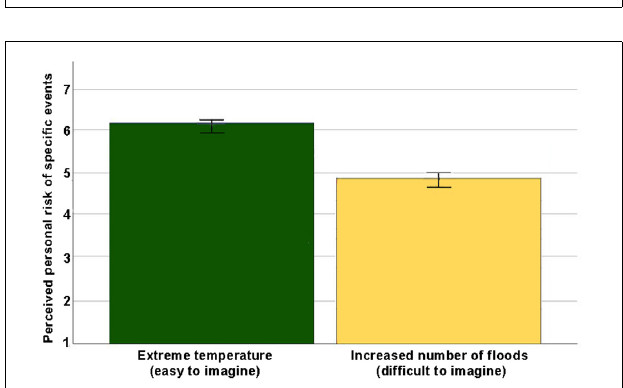
FIGURE 1 | Interaction between future thinking and type of scenario on the perceived risk of specific events.